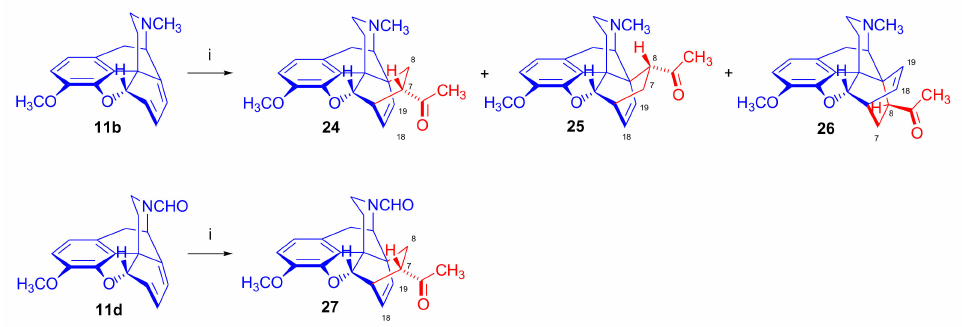
Figure 9. Cycloaddition reactions of 4- O -acetyl-6-demethoxy- N 17 -formyl- β -dihydrothebaine with methyl vinyl ketone as well as nitroethene. Reagents and conditions : (i): methyl vinyl ketone, mi- crowave heating, 20 h, (ii): nitroethene, benzene, reflux, 50 h.